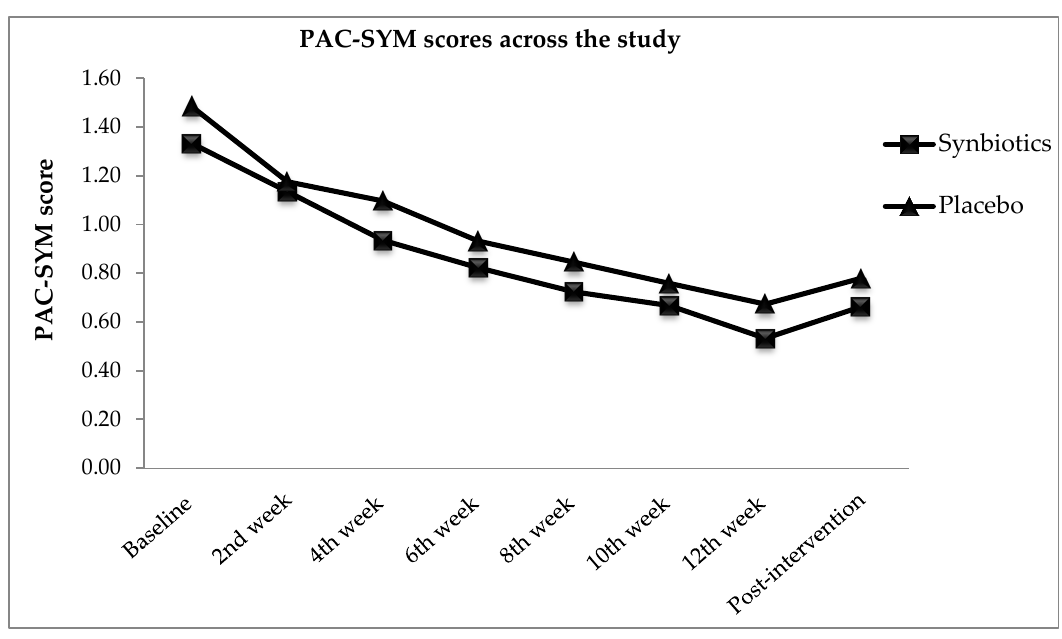
Figure 4. Patients Assessment on Constipation Symptoms (PAC-SYM) scores from baseline, intervention, and post-intervention.